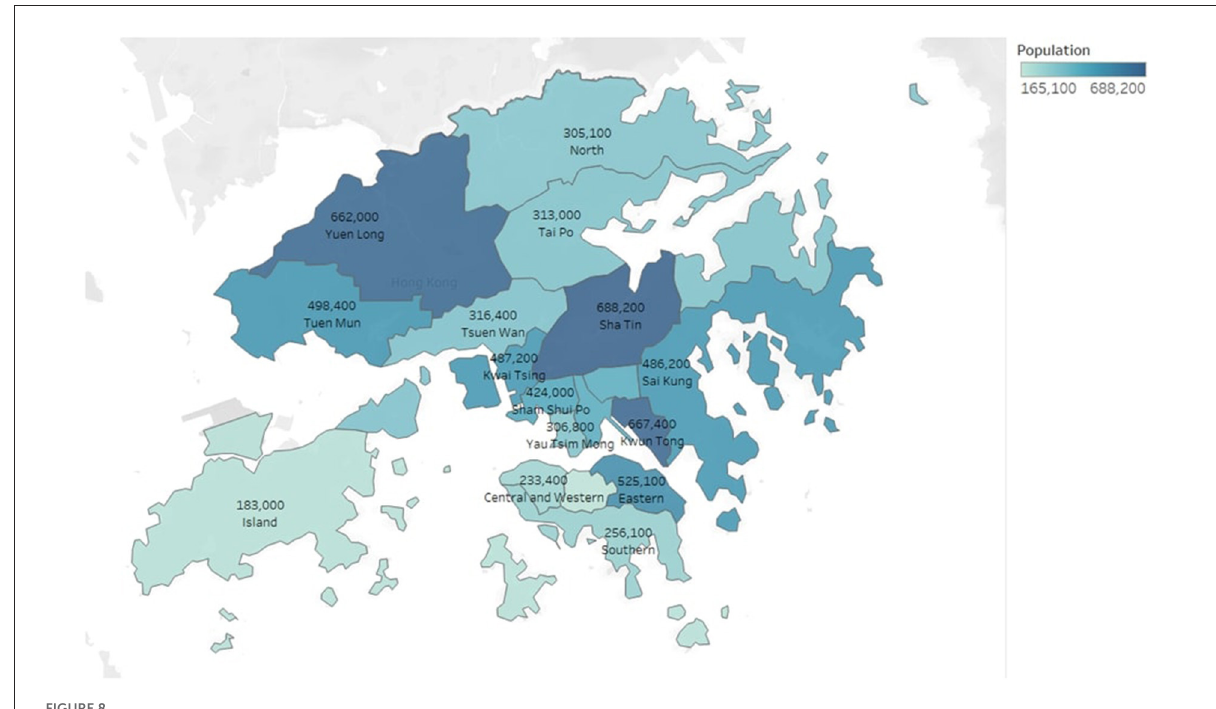
FIGURE8 Distribution of populations in Hong Kong.